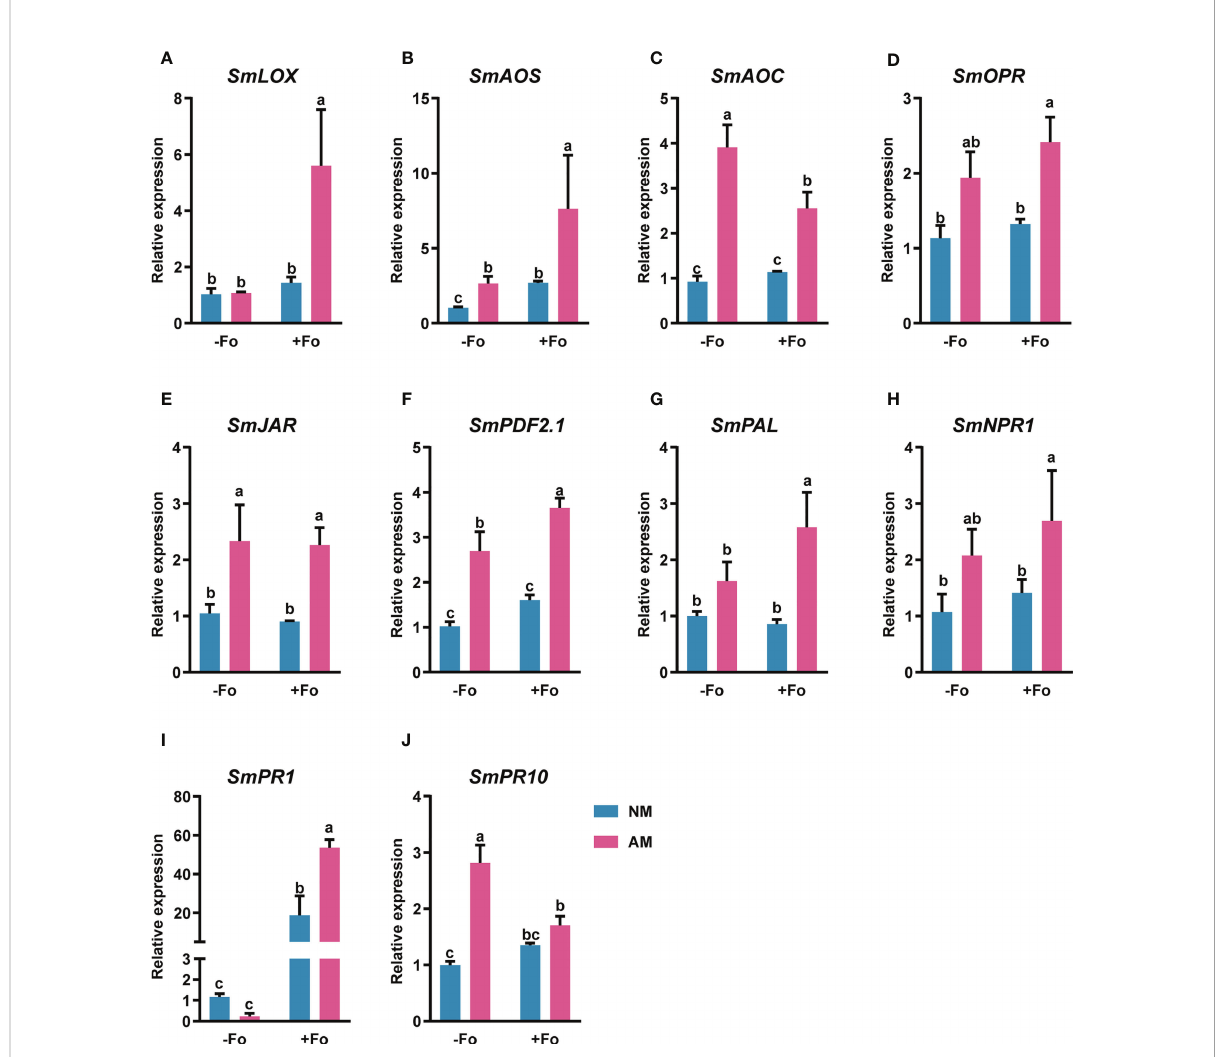
FIGURE 5 Relative expression levels of SmLOX (A) , SmAOS (B) , SmAOC (C) , SmOPR (D) , SmJAR (E) , SmPDF2.1 (F) , SmPAL (G) , SmNPR1 (H) , SmPR1 (I) , and SmPR10 (J) in the roots of S. miltiorrhiza three days after pathogen inoculation. Four treatments included: (1) NM-Fo: non-mycorrhizal S. miltiorrhiza inoculated with heat-killed pathogen inoculation; (2) NM+Fo: non-mycorrhizal S. miltiorrhiza inoculated with pathogen; (3) AM-Fo: mycorrhizal S. miltiorrhiza inoculated with heat-killed pathogen; (4) AM+Fo: mycorrhizal S. miltiorrhiza inoculated with pathogen. Values are means ± SD from four sets of independent experiments with 15 plants per treatment. Different lowercase letters indicate signi fi cant differences between different treatments according to two-way ANOVA followed by Tukey ’ s test for multiple comparisons ( P <